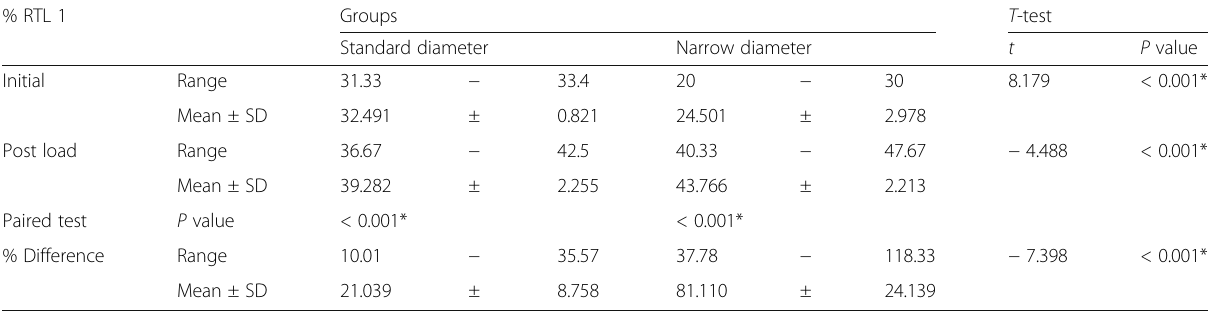
Table 1 Mean ± SD of percentage initial and percentage post load RTL 1 and percentage difference between initial and post load RTL 1 for GI and GII (regarding the screw loosening)